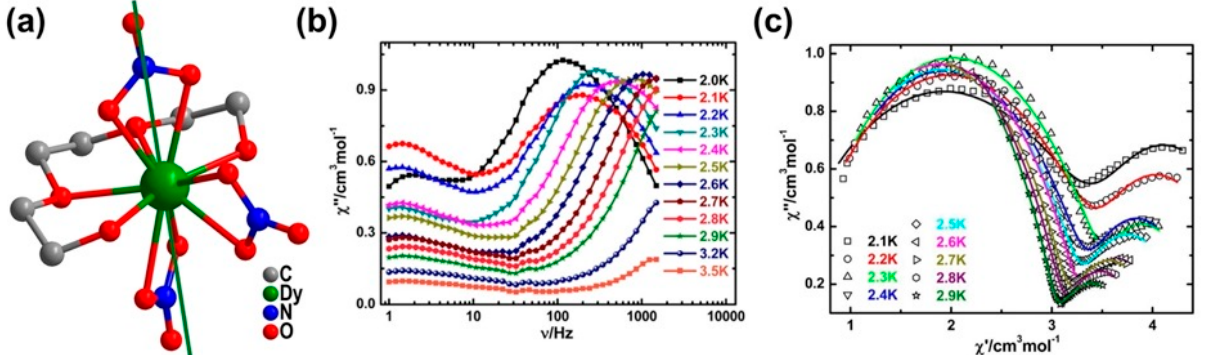
Figure 22. ( a ) Molecular structure of 37 with the magnetic easy axes, ( b ) Frequency dependence of χ ″ M signals under 1000 Oe DC field, and ( c ) Cole-Cole plots with the best fits corresponding to the sum of two modified Debye functions. Figures and captions are reproduced from Reference [58] with permission from the Elsevier Ltd.